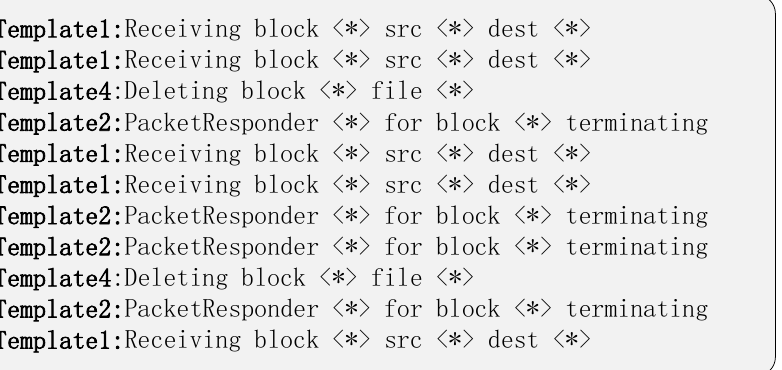
Figure 4. Log template sequence after log parsing. The “*” in the figure represents the variable part in the log